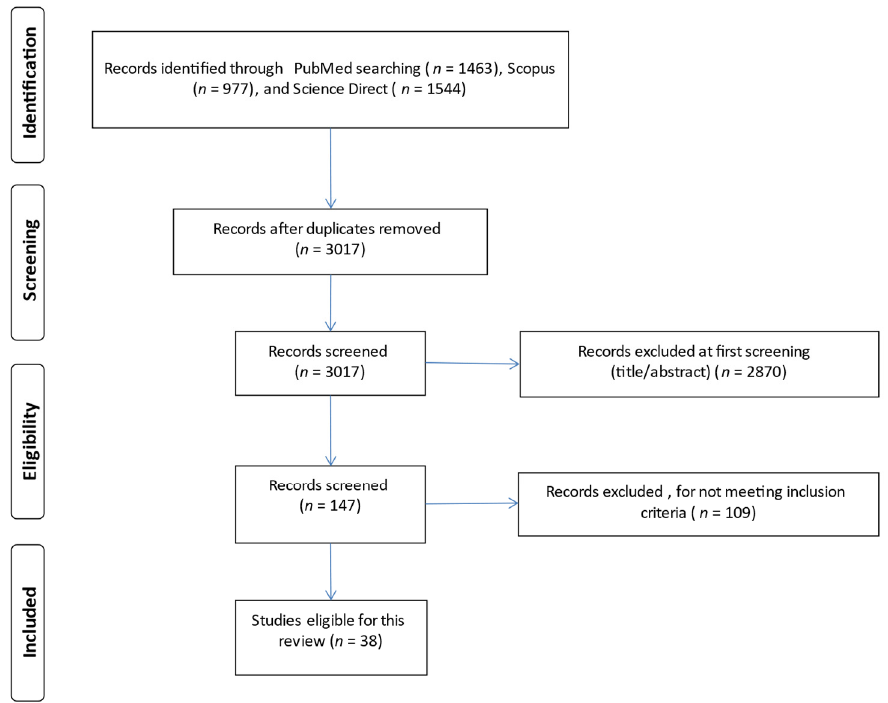
Figure 1. Flow diagram according to the Preferred Reporting Items for Systematic Reviews and Meta-Analysis.